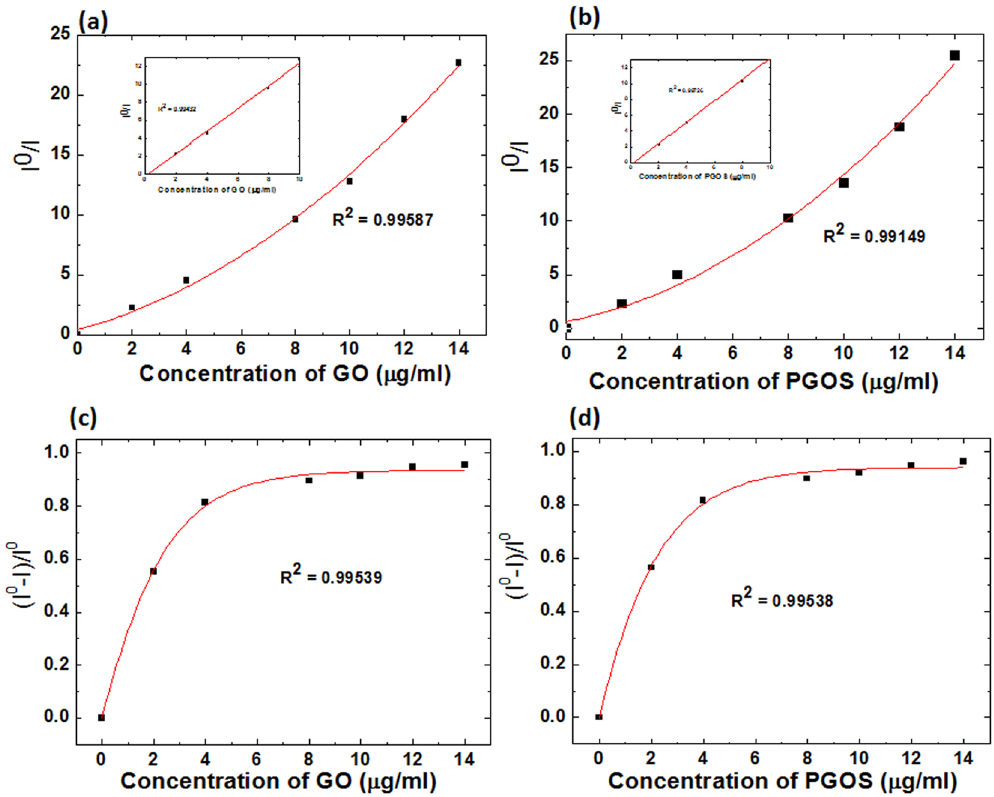
Figure 6. ( a ) Fluorescence quenching efficiency of AtTRB2 protein after treatment with GO at different concentration and ( b ) Fluorescence quenching efficiency of AtTRB2 protein after treatment with PGOS at different concentration; ( c ) Hill plots of the fluorescence quenching using GO at different concentration and ( d ) Hill plots of the fluorescence quenching using PGOS at different